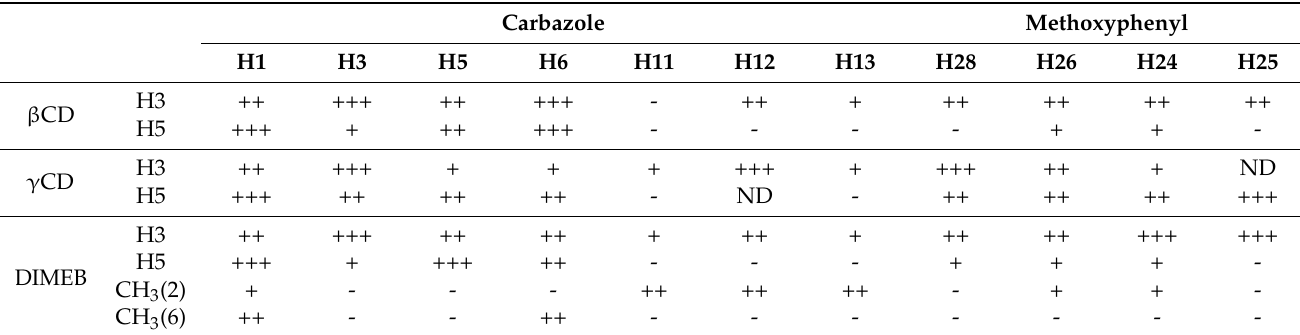
Figure 8. ( a ) A complete 2D ROESY NMR experiment (mixing time = 800 ms) with an equimolar mixture of carvedilol (2 mM) and DIMEB in 13 mM HCl in D 2 O, with an expanded region in the F2 dimension for ( b ) aromatic protons in carvedilol and ( c ) inner protons in DIMEB. Table 2. Relative intensities of dipolar correlations between protons of carvedilol and CDs, as observed in 2D ROESY